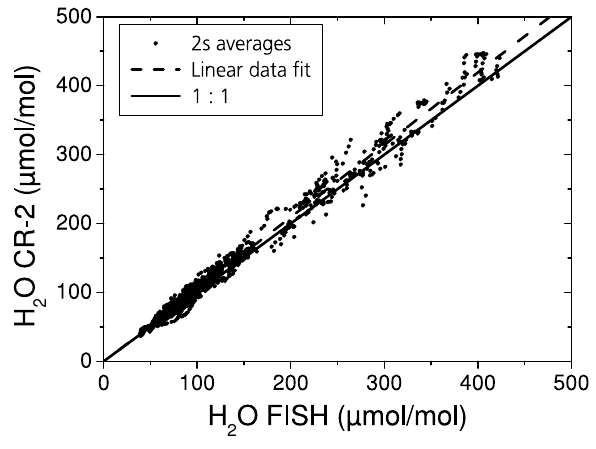
Fig. 1. Correlation of water vapor mixing ratios detected with the frost point hygrometer CR-2 and the Lyman α hygrometer FISH on 20 November 2008 above Germany. The 1:1 line and the linear regression are shown.